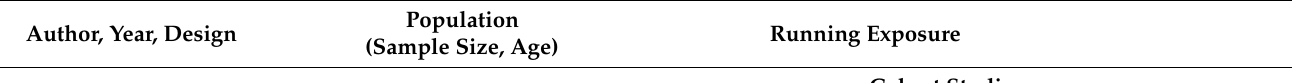
Table 1. Quantitative Study